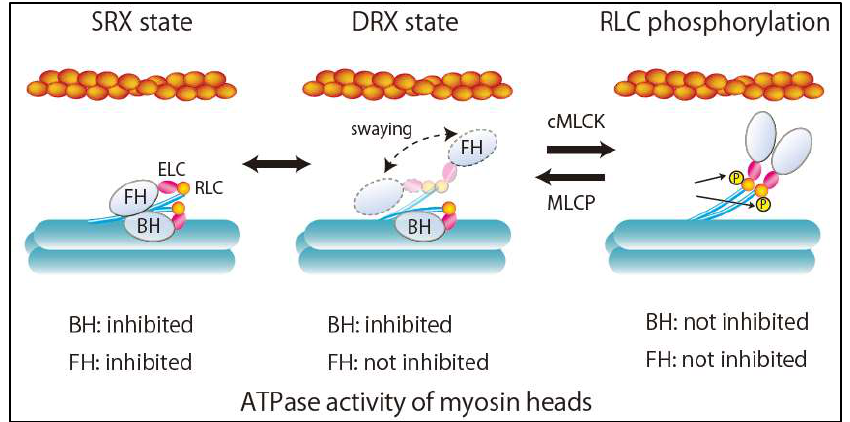
Figure 2. Structures and ATPase activity of myosin heads during relaxation states. SRX, super relaxation; DRX, disordered relaxation; FH, free head; BH, blocked head; ELC, myosin essential light chain; RLC, myosin regulatory light chain; cMLCK, cardiac myosin light chain kinase; MLCP, myosin light chain phosphatase.